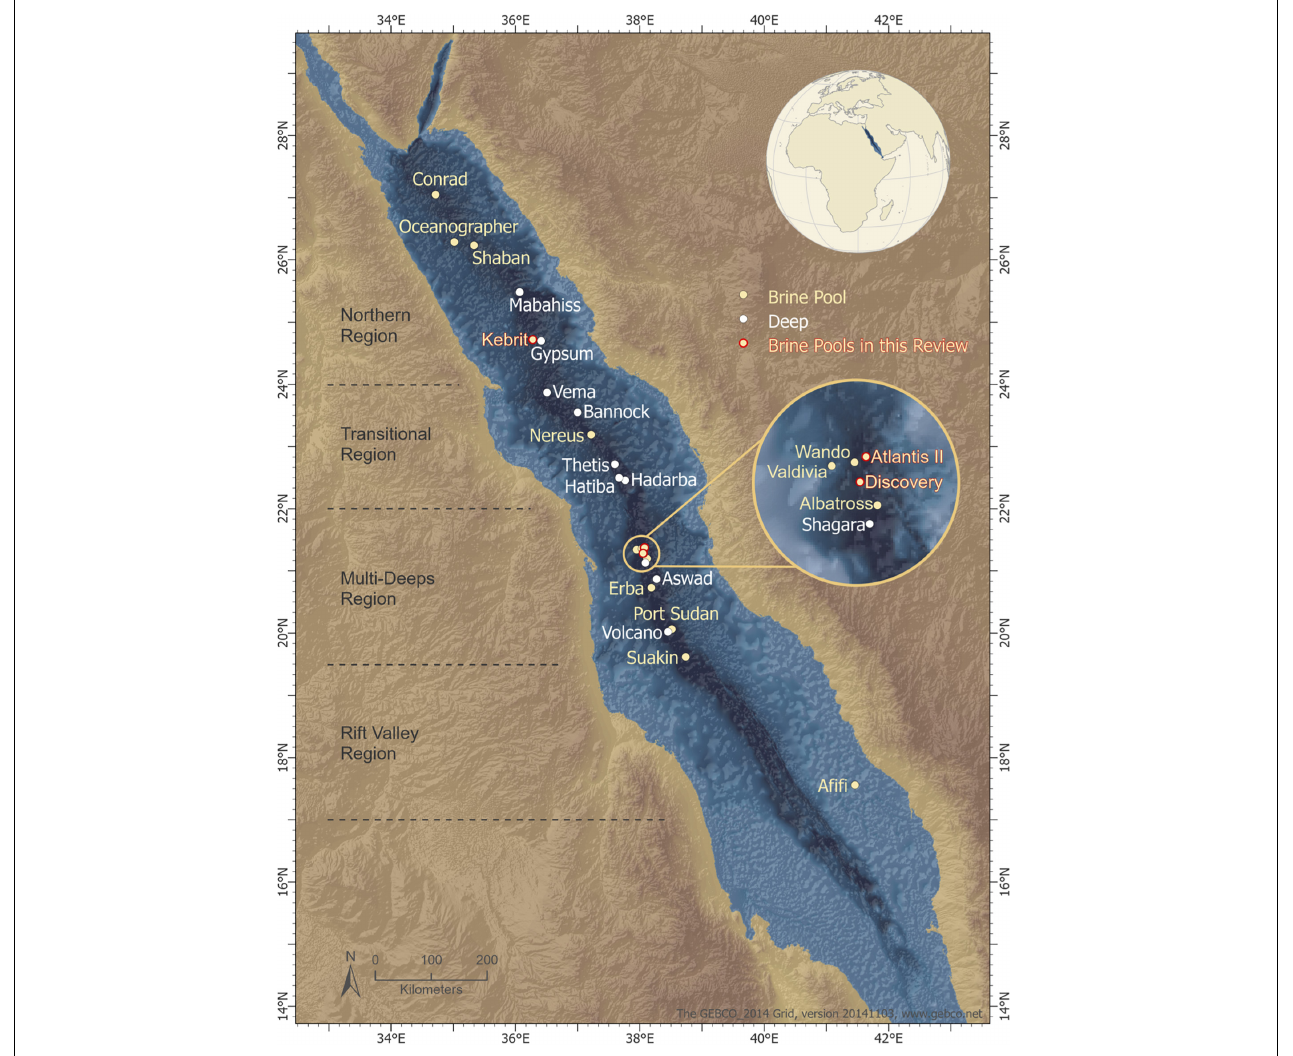
FIGURE 1 | Location of the deeps along the Red Sea rift axis. The topographic depression is segmented by its geotectonic classification, (Bonatti, 1985) and the segments consist of (i) a northern region, (ii) a transitional region, (iii) a multi-deeps region, and (iv) a rift valley region. Deeps are marked in white; brine pools are marked in beige; brine pools from which enzymes were extracted are marked in red. The geotectonic classification of Red Sea segments (gray dotted lines) is adapted from Bonatti (1985). The map was created by Ute Langner, Red Sea Research Center